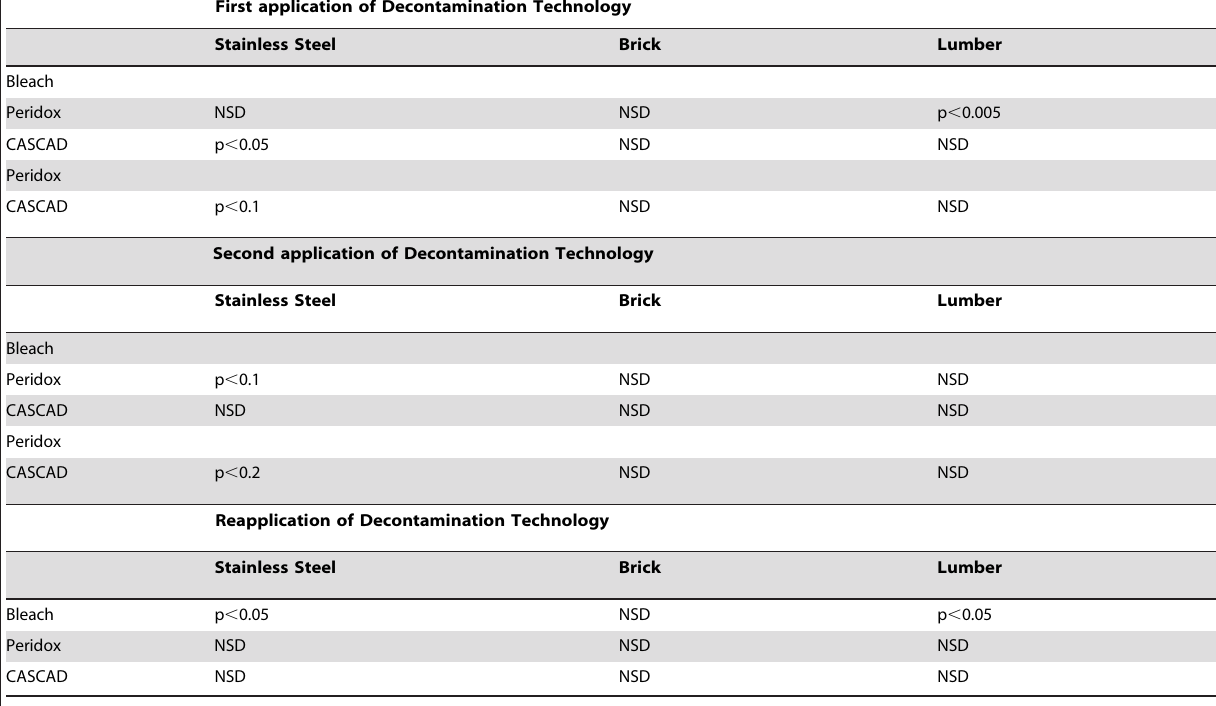
Table 4. Pair-wise Efficacy Analysis of Decontamination Technologies.